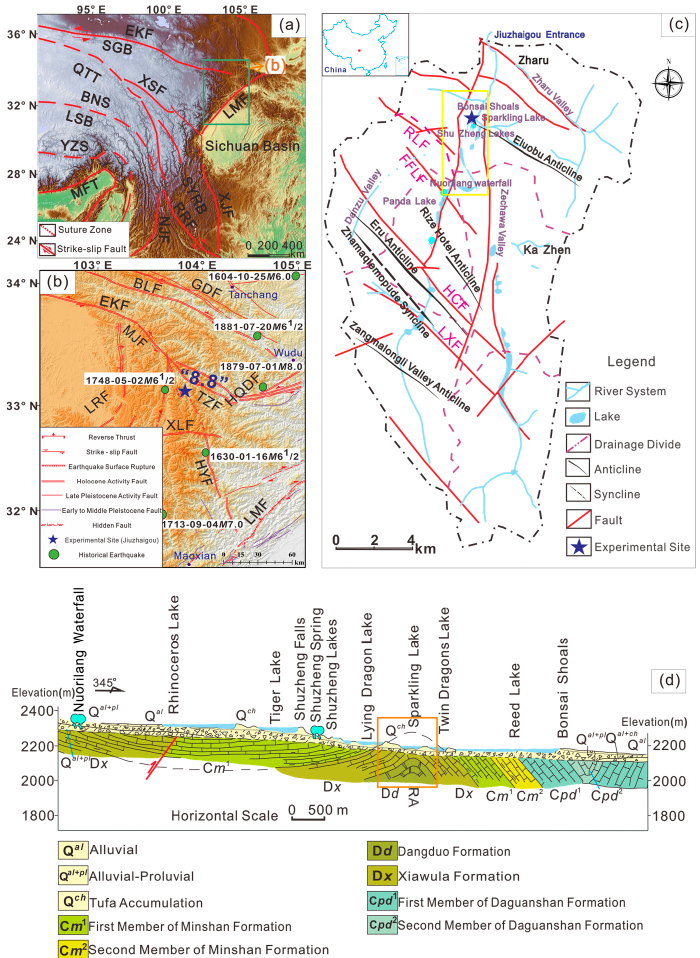
Figure 1. Geological background map of study area. ( a ) Regional tectonic geological map [36]. EKF = East Kunlun fault; XSF = Xianshuihe fault; QTT = QiangTang terrane; BNS = Bangong-Nujiang suture; LSB = Lhasa block; YZS = Yarlung-Zangbo suture; MFT = main frontal thrust; NJF = Nujiang fault; RRF = Red River fault; SYRB = Sichuan-Yunnan rhombic block; XJF = Xiaojiang fault; LMF = Longmenshan fault; SGB = Songpan-Ganzi Block. The green frame is the area in Figure b. ( b ) Regional structure and distribution of magnitude M ≥ 6.0 earthquakes in the Jiuzhaigou vicinity between 1630 and 1900 [37]. The blue frame shows the location of the Jiuzhaigou Scenic Spot. GDF = Guanggaishan-Dieshan fault; BLF = Bailongjiang fault; EKF = East Kunlun fault; MJF = MinJiang fault; TZF = Tazang fault; XLF = Xueshanliangzi fault; LMF = Longmenshan fault; HYF = Huya fault; LRF = Longriba fault; HQDF = Hanan-Qingshanwan-Daoqizi fault. The blue five-pointed star is the epicenter of the “8.8” earthquake. ( c ) Outline of the geological structure of the Jiuzhaigou Scenic Spot (from Sichuan Provincial Regional Geological Survey Team 2006). The yellow frame shows the location of Shuzheng Valley. The location of Sparkling Lake is indicated by a blue five-pointed star. LXF = Long Lake-XuanquanValley Fault; HCF = Hawk Claw Fault; FFLF = Five Flower Lake Fault; RLF = Rhinoceros Lake Fault. ( d ) Schematic of the Shuzheng Valley geological profile [38]. RA = Russian Anticline. The orange frame shows the location of the Sparkling Lake in the Shuzheng Valley profile.